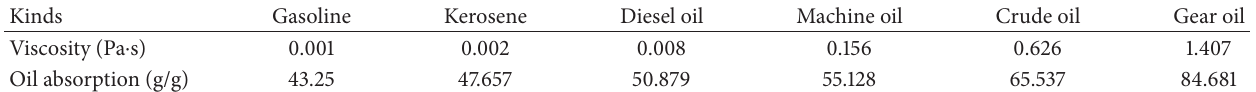
Table 1: The effect of oil viscosity on sorption capacity of the MEG.